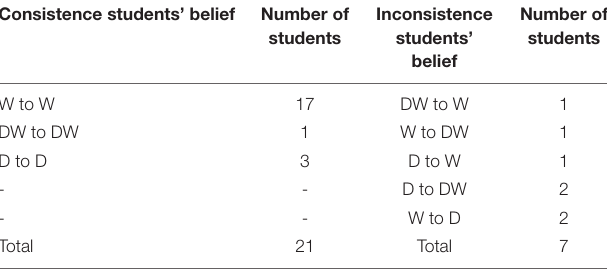
TABLE 6 | Students’ belief in teacher EYL profession. Consistence students’